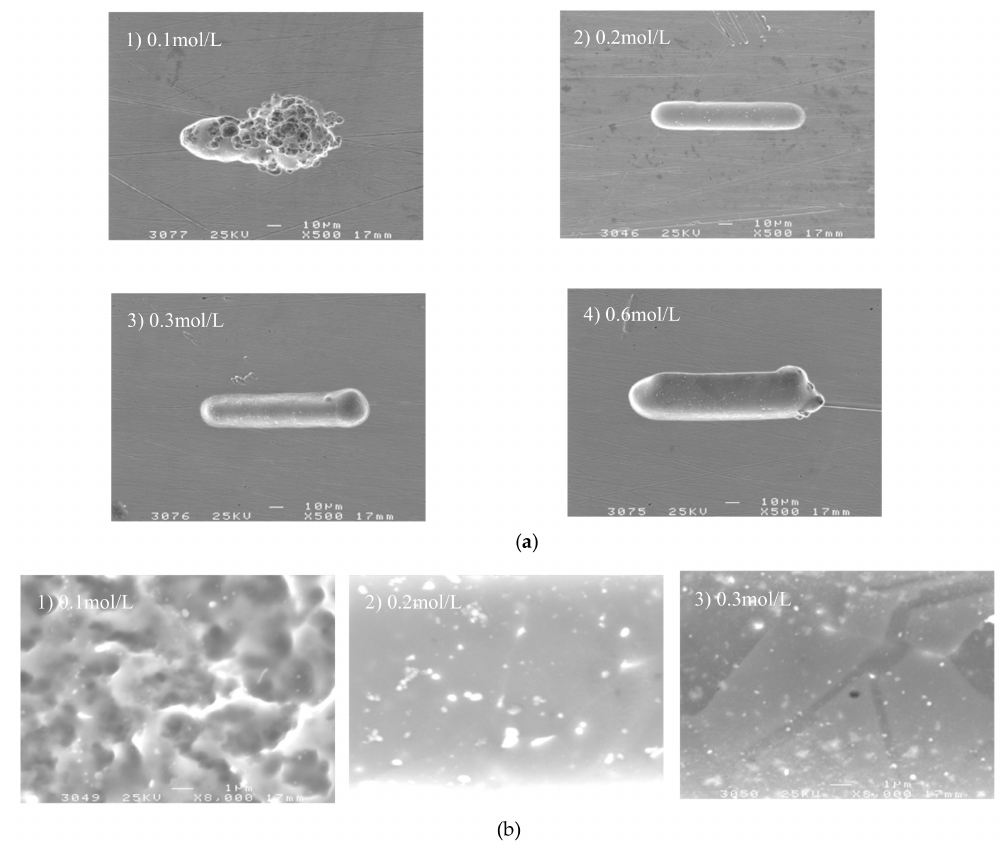
Figure 12. The microgroove under different electrolyte concentrations. ( a ) The SEM images of the microgroove; ( b ) The appearance of the